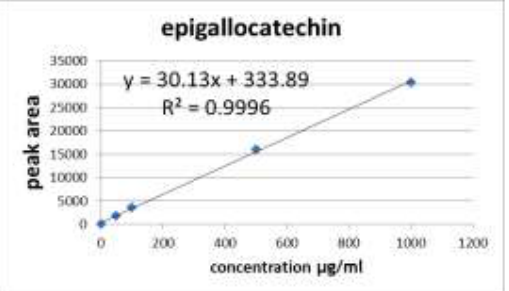
Figure 4 . Standard curves of